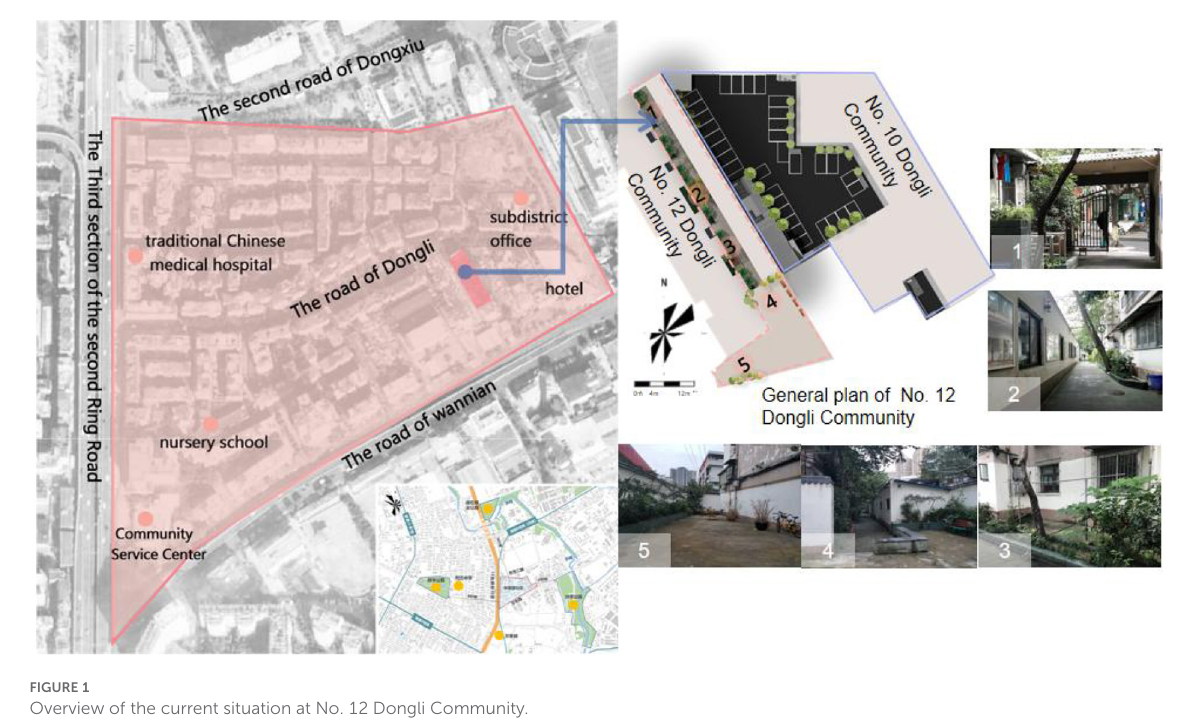
FIGURE1 Overview of the current situation at No. 12 Dongli Community.